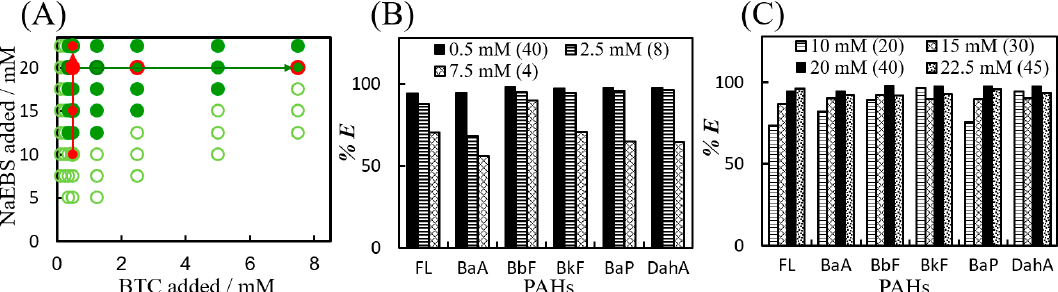
Figure 4. Effect of the concentrations of BTC and NaEBS on the percent extraction (% E ) of PAHs extracted from an aqueous solution using liquid organic IAP. ( A ) % E of PAHs obtained with concentrations of BTC and NaEBS in the region of formation of IAPs. ( B ) Effect of the concentration of BTC on the % E of PAHs obtained by liquid organic IAP extraction from an aqueous solution. ( C ) Effect of the concentration of EBS ion on the % E of PAHs by liquid organic IAP extraction from an aqueous solution. BTC: benzethonium chloride, NaEBS: sodium ethylbenzenesulfonate, FL: fluoranthene, BaA: benzo[a]anthracene, BbF: benzo[b]fluoranthene, BkF: benzo[k]fluoranthene, BaP: benzo[a]pyrene, and DahA: dibenzo[a.h]anthracene.